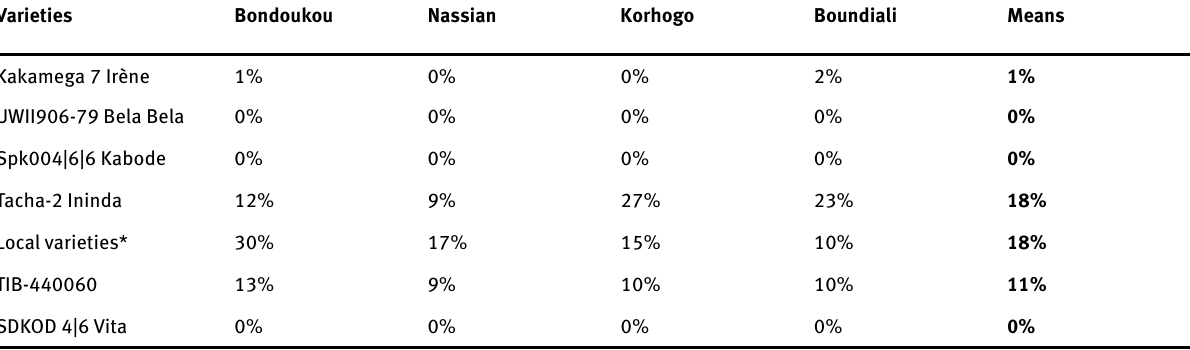
Table 3 : Incidence of virus observed with varieties in different localities Varieties Bondoukou Nassian Korhogo Boundiali Means Kakamega 7 Irène